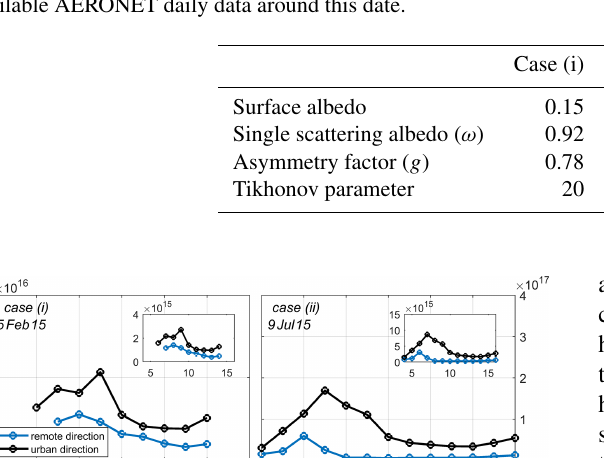
Table 3. Settings used for the BOREAS retrieval. The mean daily value of each parameter ( ω and g retrieved from AERONET) is mentioned for cases (i), (ii) and (iii). The mean monthly values of ω and g (provided from AERONET for April 2017) were used for case (iv) due to unavailable AERONET daily data around this date.